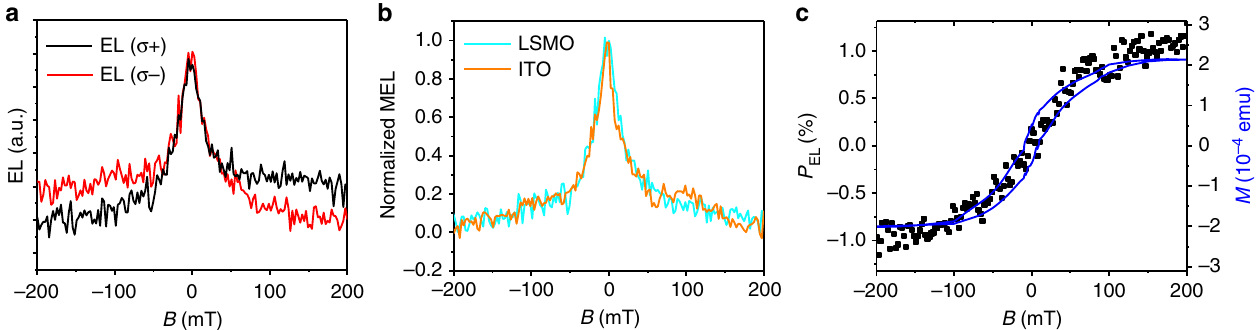
Fig. 3 Circularly polarized electroluminescence emission from MAPbBr 3 spin-LED. a EL( σ + ) and EL( σ − ) circularly polarized EL emission as a function of an applied magnetic fi eld measured at 10 K and applied bias of 9 V. b The sum of the right and left circular polarized EL( B ) response of the spin-LED, compared with MEL( B ) response of a traditional LED with no FM electrodes, where the LSMO was replaced by indium tin oxide (ITO). c The degree of circular polarization in the EL( B ) response. The blue solid line is the magnetization hysteresis loop of the LSMO electrode measured using SQUID